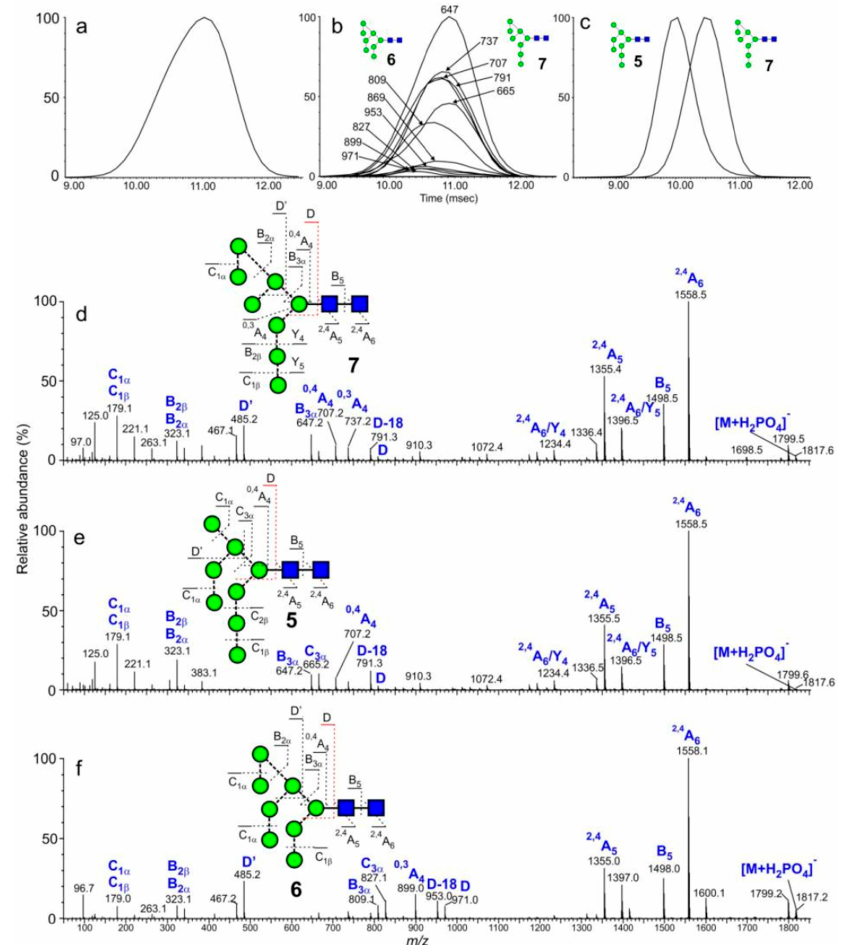
Figure 22. ( a ) Negative ion ATD profile (smoothing algorithm, mean 2 × 2) of Man 8 GlcNAc 2 ([M + H 2 PO 4 ] − ion) from gp120. ( b ) Single ion plots of the diagnostic 6-antenna-specific product ions from Man 8 GlcNAc 2 (mainly isomer 7) obtained from gp120 (smoothing algorithm, mean 2 × 2). ( c ) Negative ion ATD profiles (smoothing algorithm, mean 2 × 2) of the d1d1d2 (5) and d1d1d3 (7) isomers of Man 8 GlcNAc 2 ([M + H 2 PO 4 ] − ions). Spectra were from different samples and normalized to 100%. ( d ) Negative ion CID spectrum ([M + H 2 PO 4 ] − ion) of Man 8 GlcNAc 2 (d1d1d3 isomer, 7,